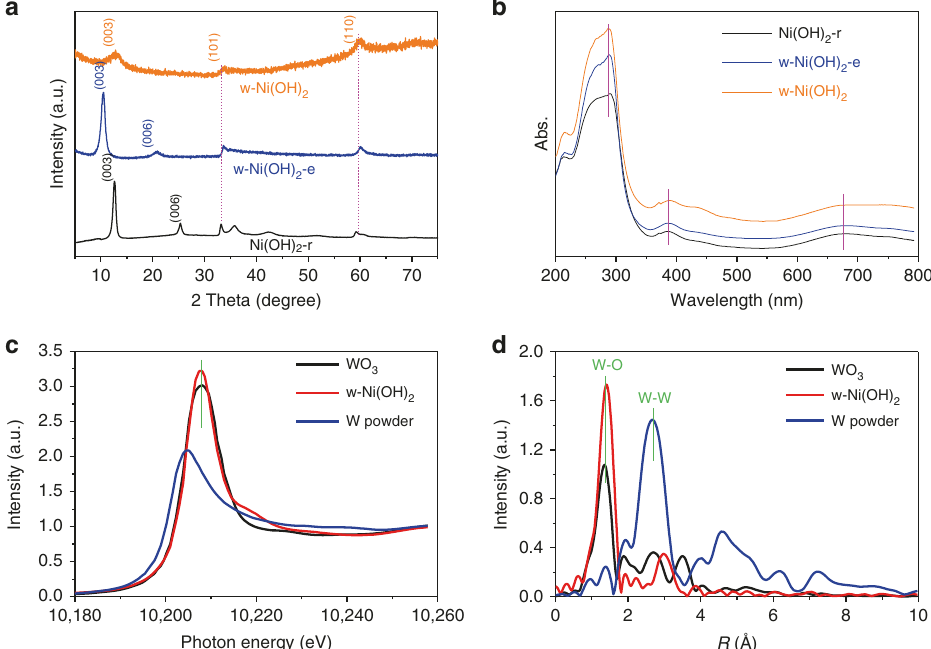
Fig. 2 Physicochemical property characterization. a XRD patterns of the reference Ni(OH) 2 -r, w-Ni(OH) 2 -e, and w-Ni(OH) 2 samples; b UV – Vis absorption spectrum; c The W K-edge XANES spectra, and d the corresponding K 2 -weighted Fourier transform spectra of w-Ni(OH) 2 , WO 3 , and W powder were used as the reference